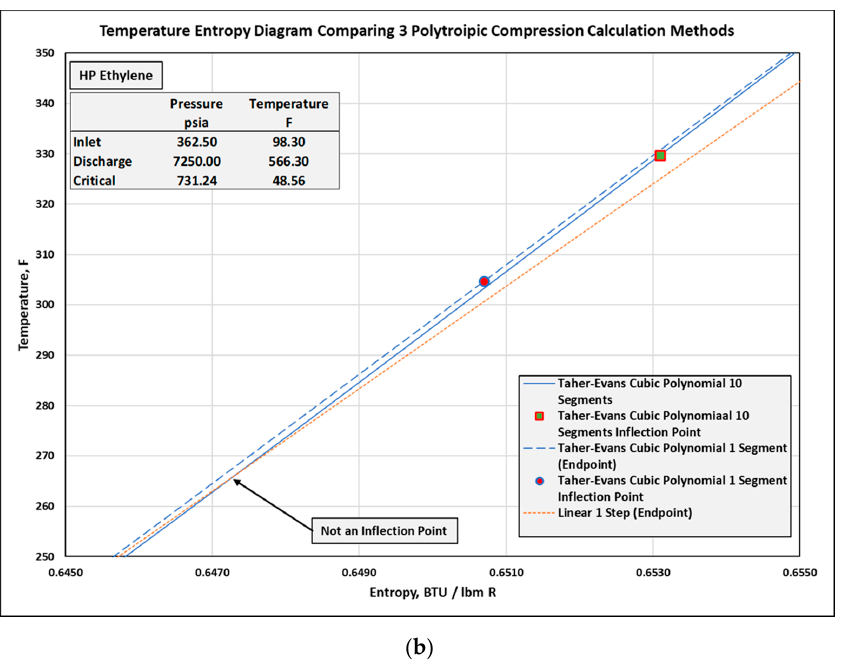
Figure A5. ( a ) T-s compression paths for HP ethylene example case. ( b ) the location of inflection point on T-s compression polytropic path is compared for different methods—HP ethylene example